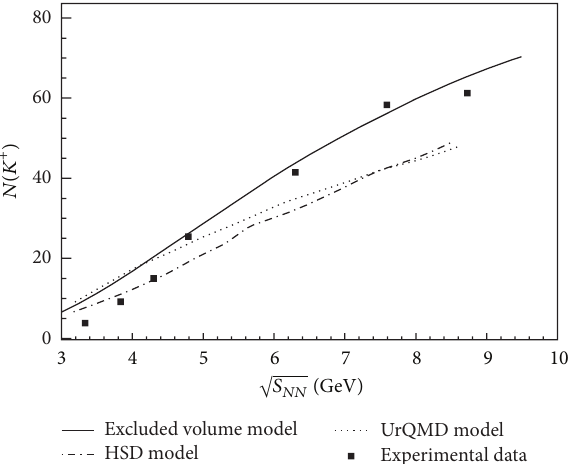
Figure 3: Variation of total multiplicity of produced 𝐾 + with respect to √𝑠 𝑁𝑁 . Dash-dotted and dotted curves are the results obtained from HSD and UrQMD models, respectively [29]. Experimental data is taken from [30–35].